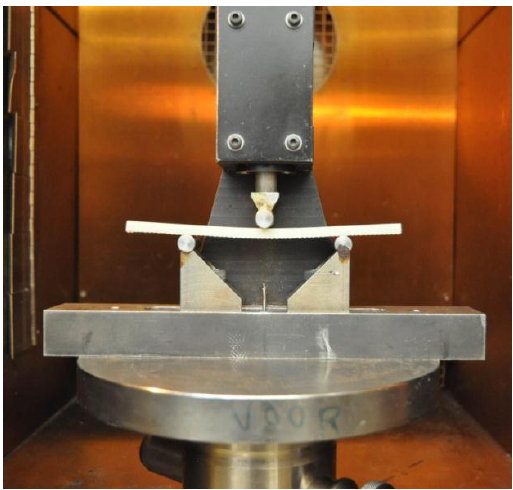
Figure 3. Flexural test device.